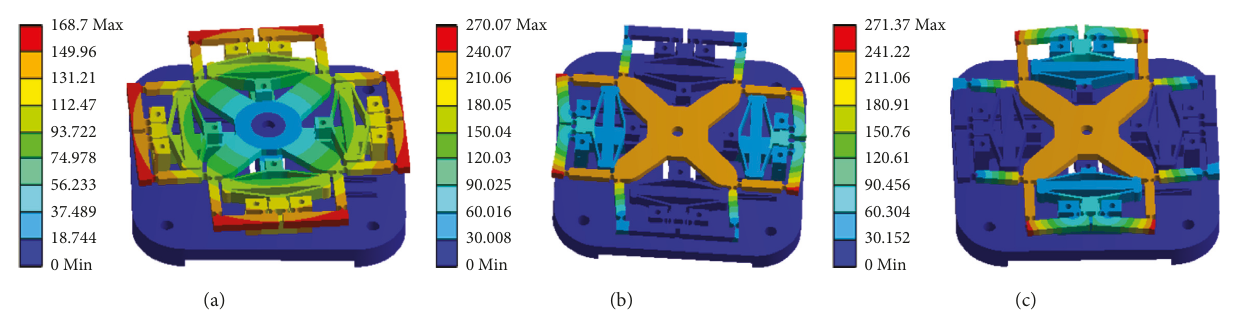
Figure 15: Modal shapes of the structure in (a) θ